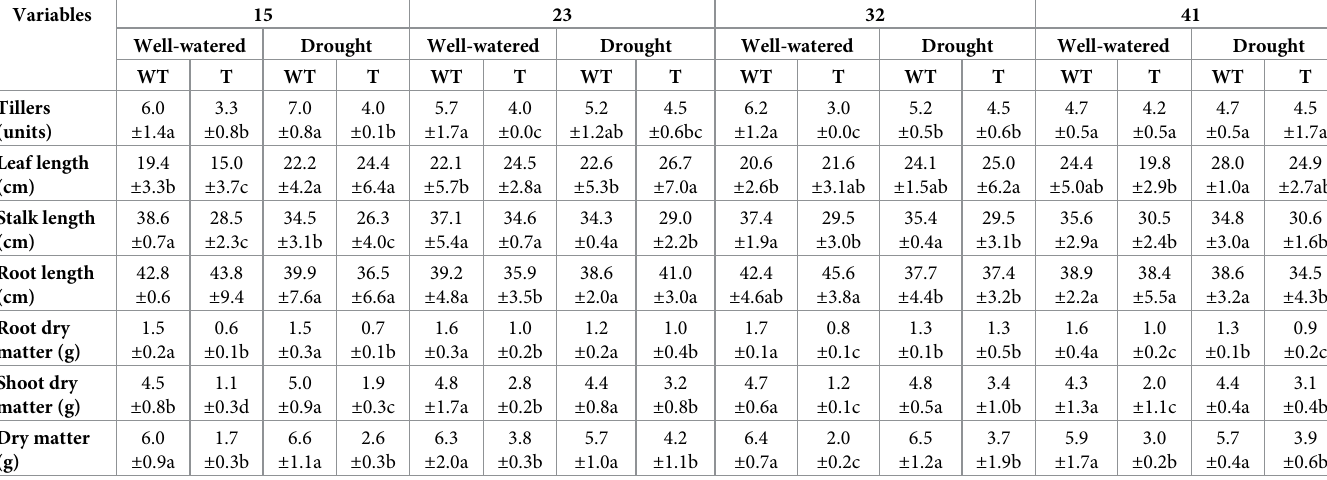
Table 3. Biometric parameters evaluated in the transgenic lines ScMYBAS1-2 under well-watered and drought conditions at maximum stress. Variables 15 Well-watered Tillers